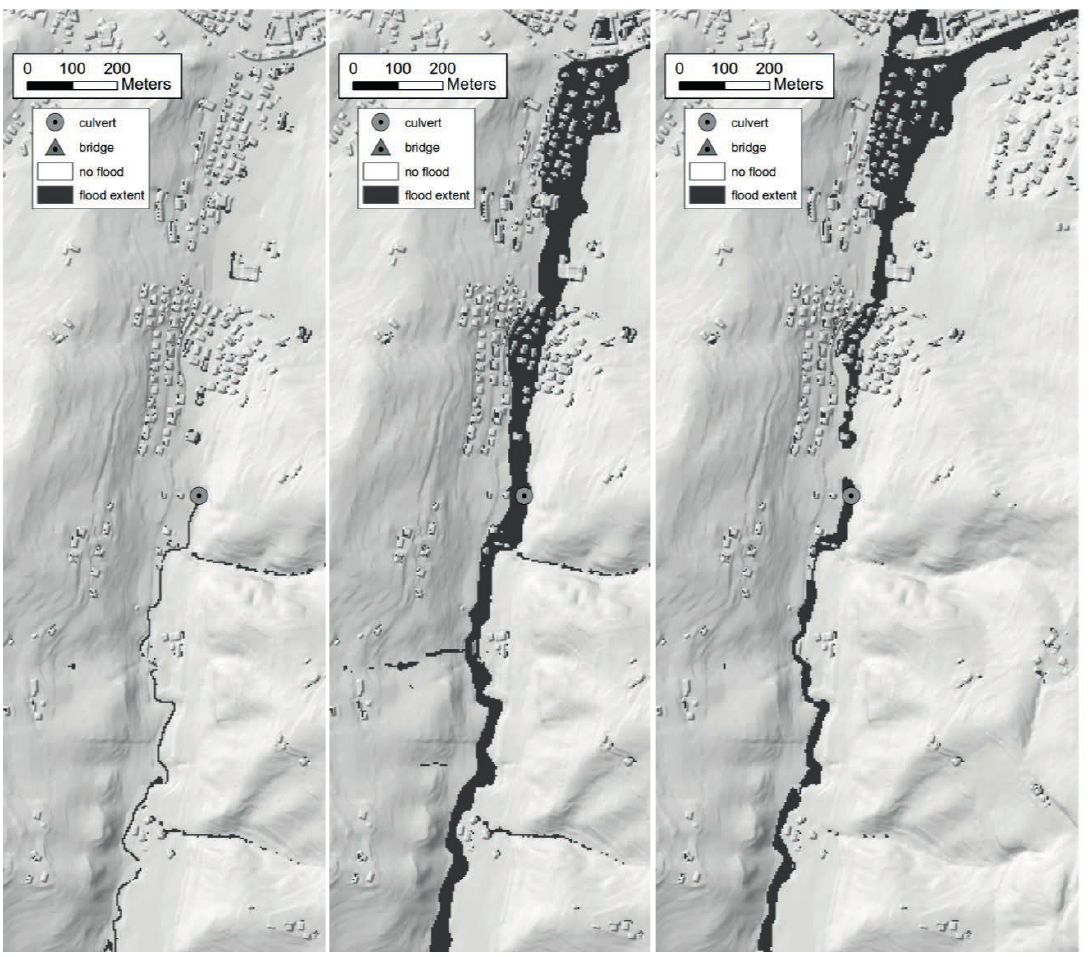
Fig. 3 Results of historical scenario. Flood extent (dark grey) in the lower part of the catchment at time t = 30 minutes (left), t = 90 minutes (centre), t =150 minutes (right). The small black circle indicates the culvert